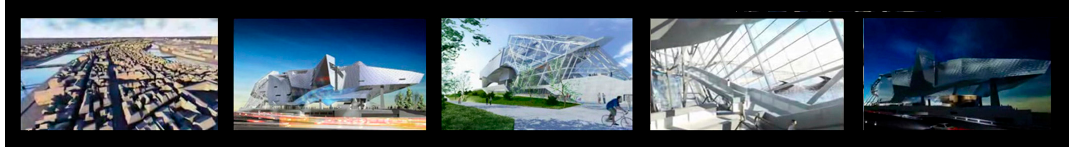
Figure 3. Coop Himmelb(l)au, Musée des Confluences in Lyon. Movie by Isochrom (7:30),